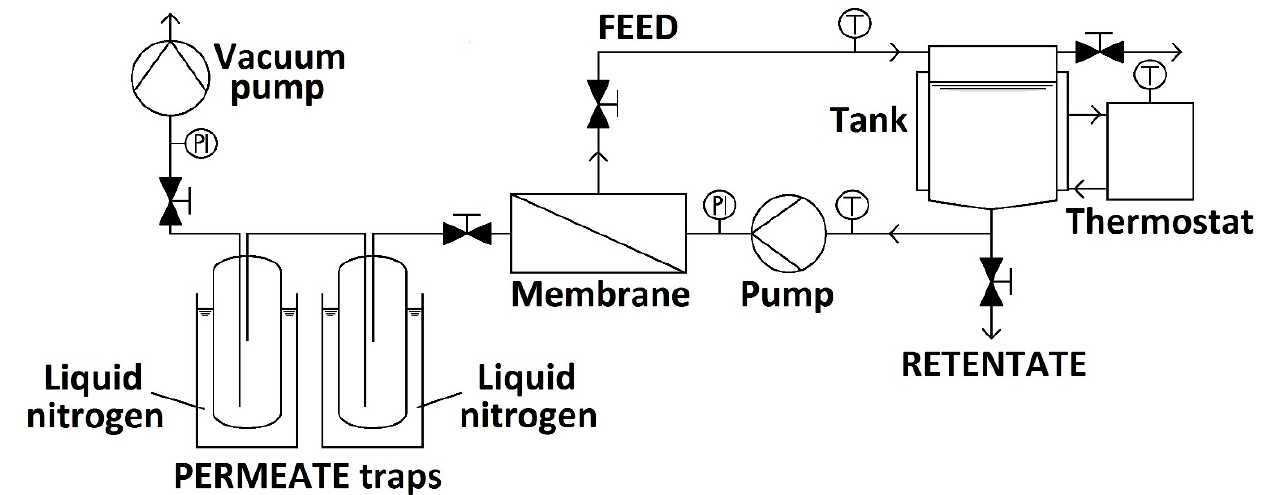
Figure 2. CM-Celfa P-28 Membrantechnik AG apparatus in the pervaporation setting